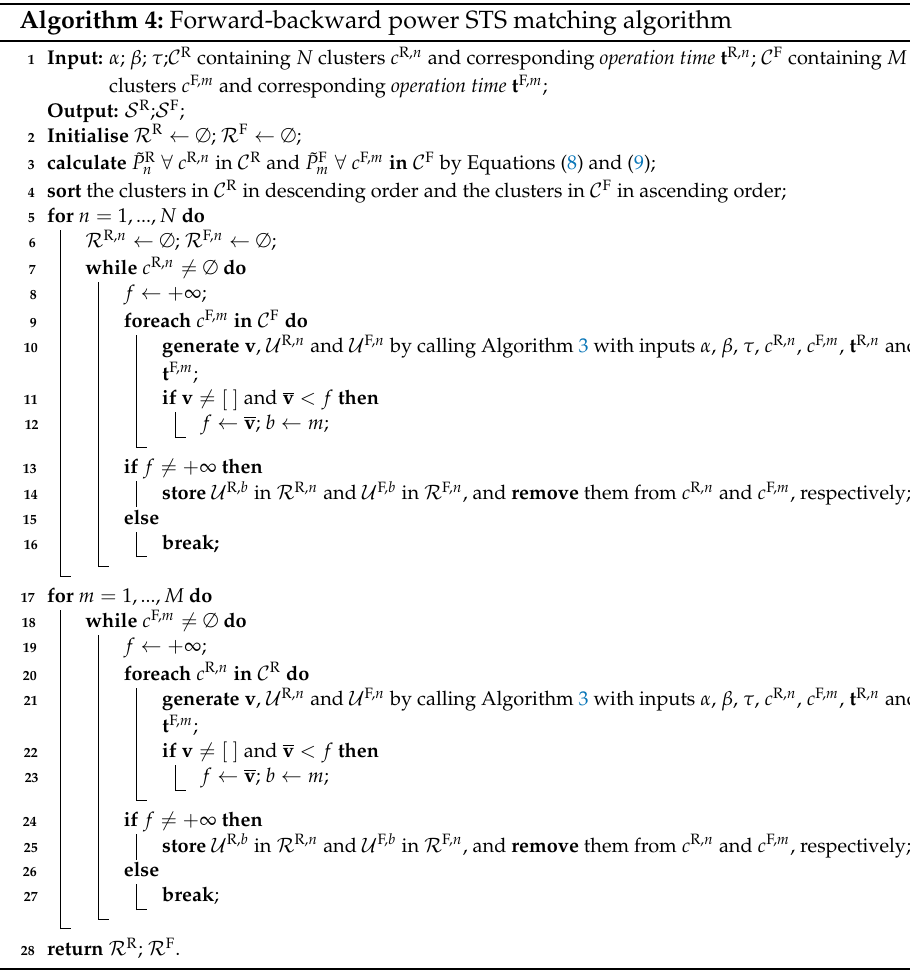
Algorithm 4: Forward-backward power STS matching